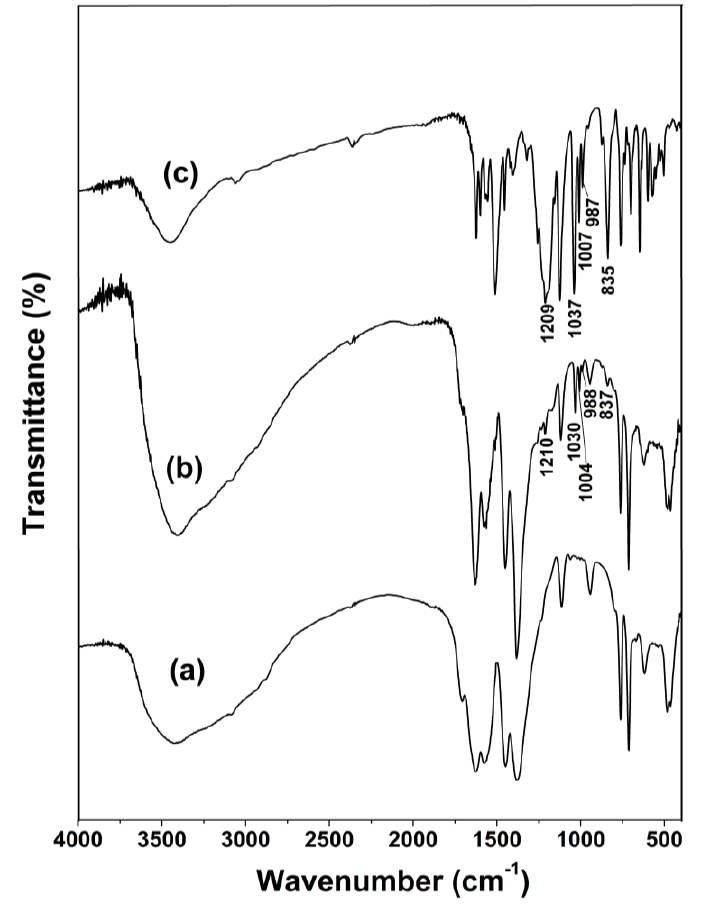
Figure 2. FTIR spectra of ( a ) Fe(BTC) material; ( b ) Fe(BTC) with adsorbed azo-dye Orange II dye and ( c ) azo-dye Orange